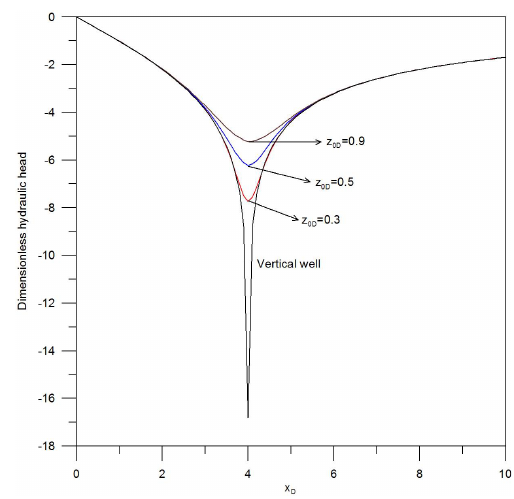
Fig. 7. The spatial head distribution for κ y = 1, κ z = 1, x 0 D = 4, L D = 1, and various depth of the horizontal well parallel to the